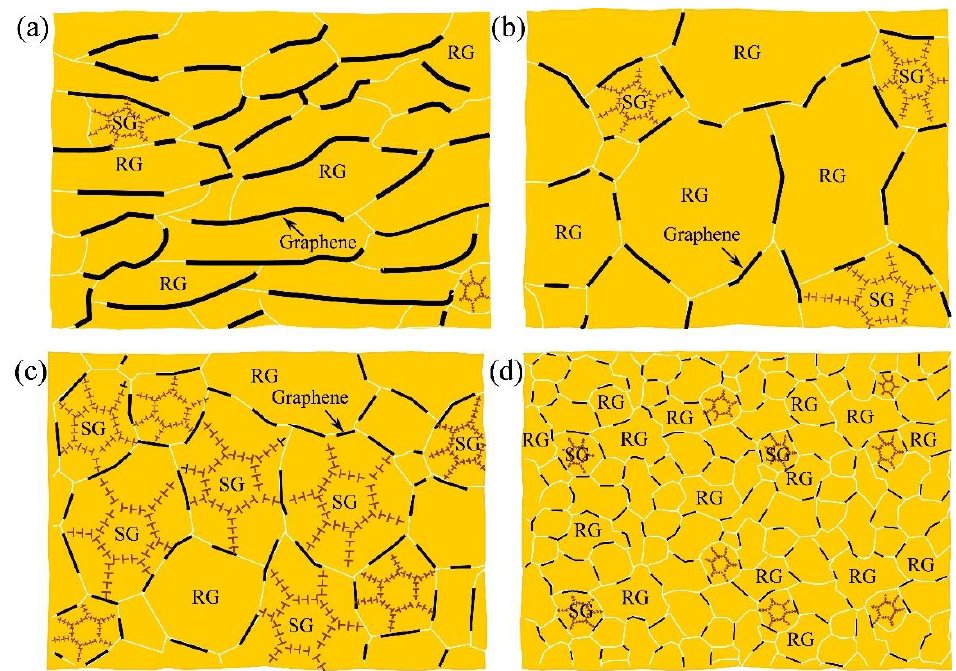
Figure 12. An illustration scheme of the evolution of graphene and matrix during the drawing process (on the ND–TD plane). ( a ) As-sintered composite, ( b ) as-extruded composite, ( c ) as-drawn composite dominated by substructured grains (SG) and ( d ) as-drawn composite dominated by recrystallized grains (RG).